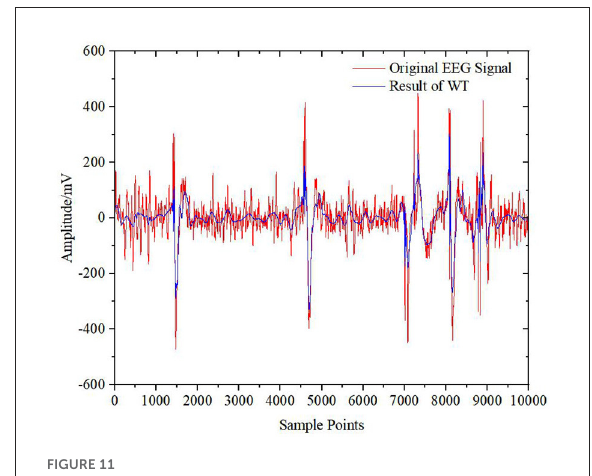
FIGURE11 Raw EEG signal and result of WT.